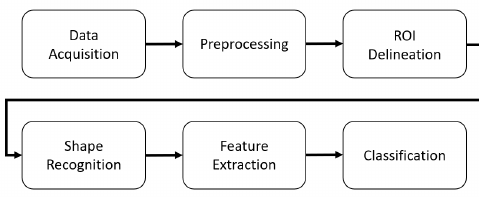
Figure 1. Workflow.